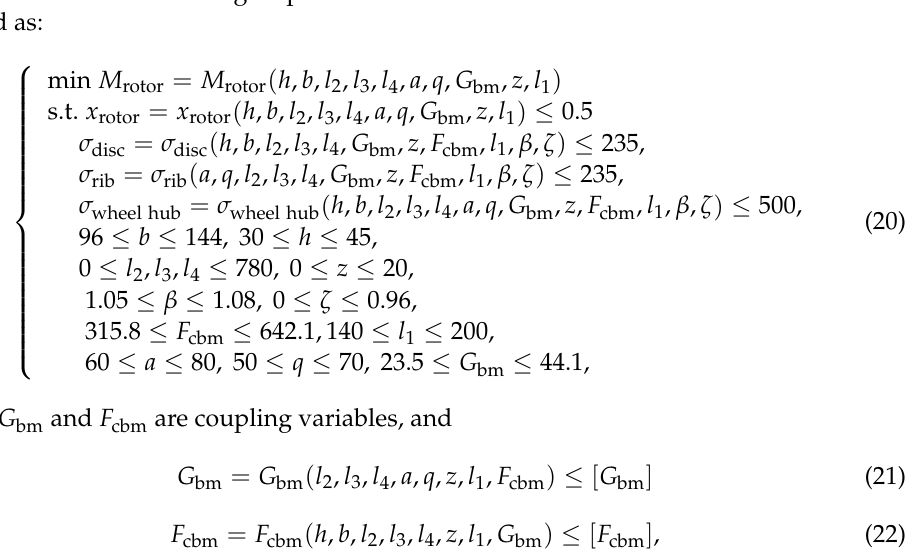
Figure 8. Disciplinary coupling relationship of the rotor mechanism.